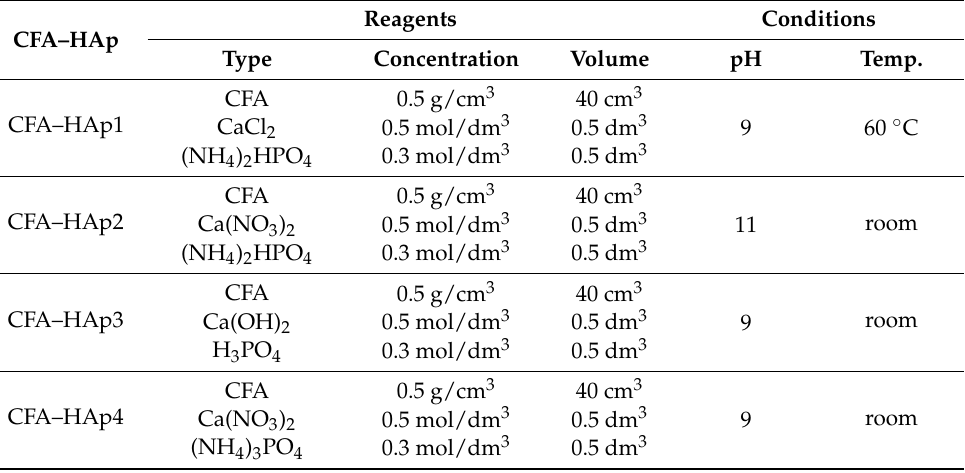
Table 1. Reagents and reaction conditions corresponding to the synthesis of each of the four CFA– HAp composites, as